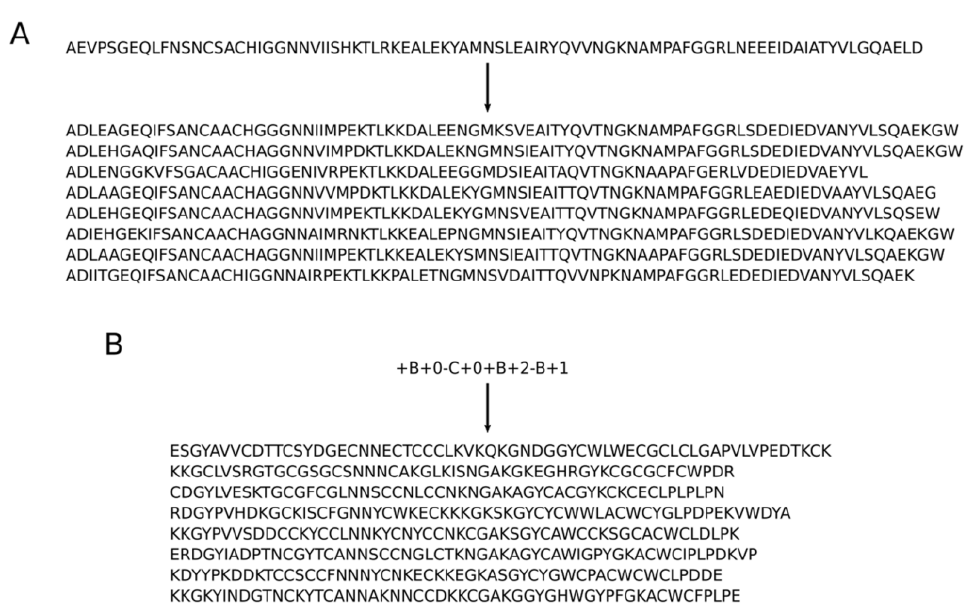
Figure 1. Amino acid sequences generated by CVAE as determined by ( A ) similarity to input